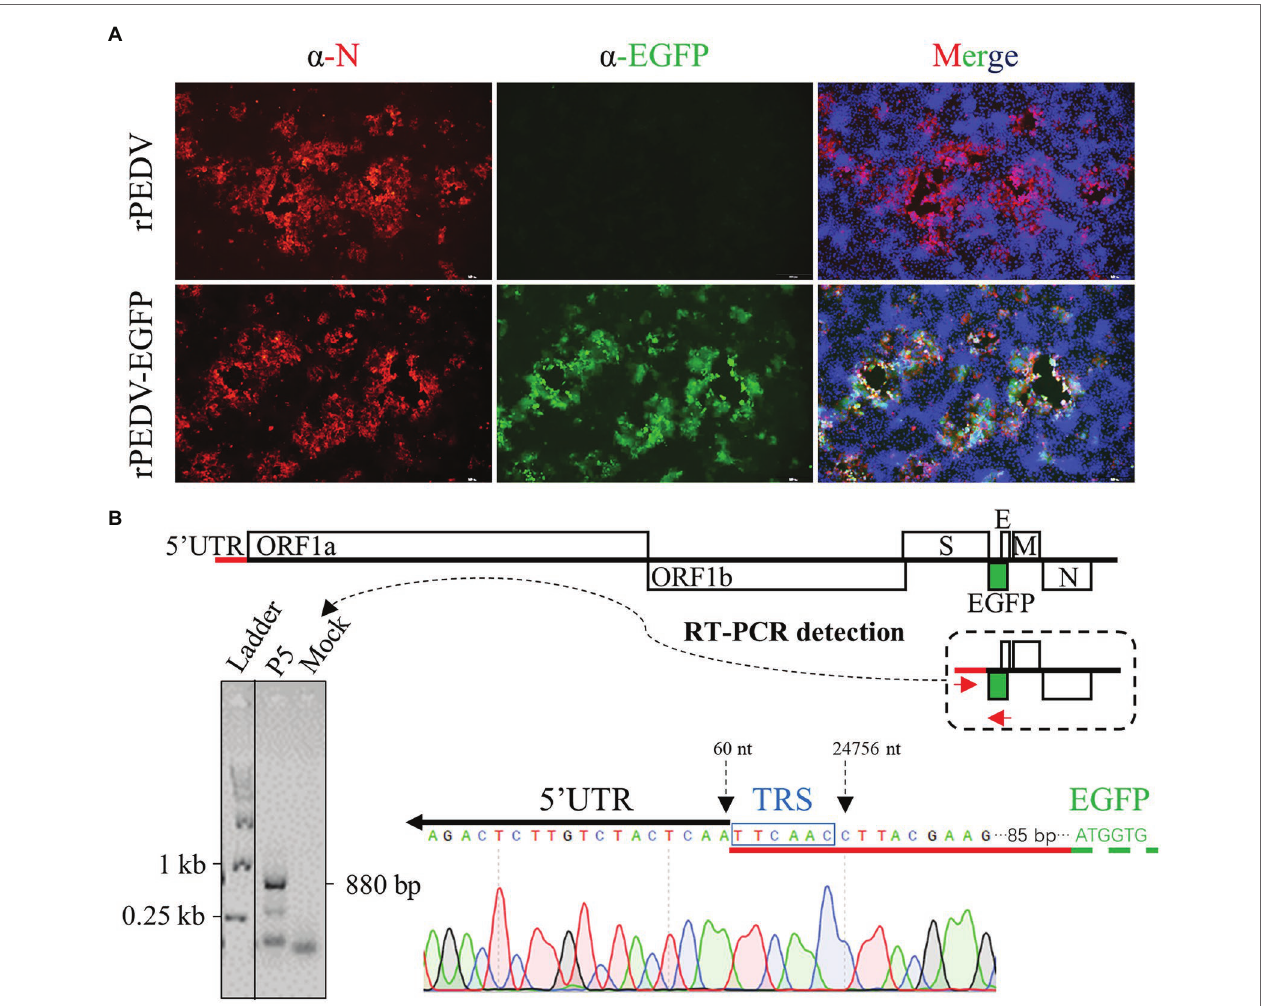
FIGURE 6 | Recovery and verification of rPEDV-EGFP. (A) N protein expression detection by indirect immunofluorescence assay (IFA). Vero CCL-81 cells were infected rPEDV or rPEDV-EGFP at an MOI of 0.1. At 24 h post-infection (hpi), cells were fixed and stained with a mAb against PEDV N protein followed by incubation with TRITC-conjugated goat anti-mouse IgG(H + L). Cell nuclei were counterstained with DAPI. Pictures were taken under the IX73 epifluorescence microscope (Olympus). (B) Identification of the subgenomic RNA expressing EGFP in rPEDV-EGFP infected Vero CCL-81 cells. Vero CCL-81 cells infected with rPEDV-EGFP P5 at an MOI of 0.1 MOI or mock-infected were harvested with TRIzol reagent (Vazyme). Total cellular RNA was extracted and used for RT-PCR amplification of the subgenomic RNA expressing EGFP using primers YES1L-PEDV-F1 and EGFP-R. The expected size of this amplicon is around 880 bp in length. The body TRS- leader TRS junction was identified by DNA sequencing with the